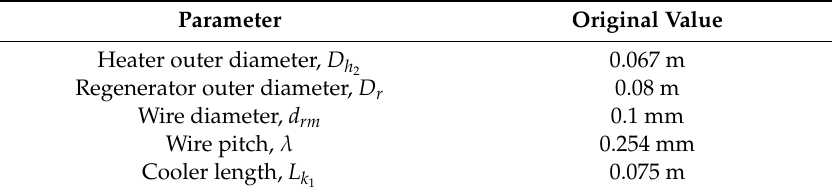
Table 4. Designed parameters and their original values.